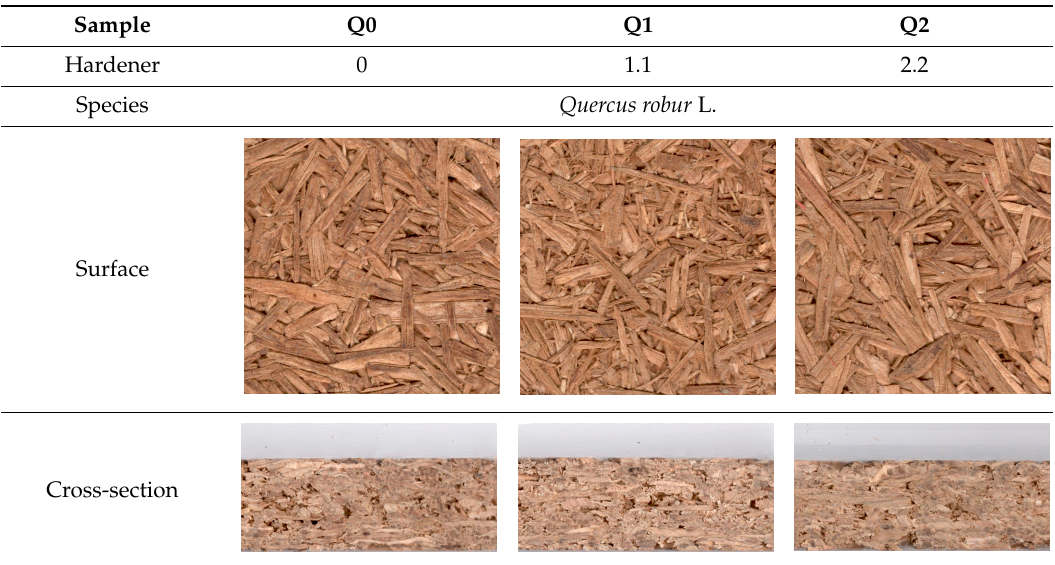
Table 4. Sample appearance of the boards made of oak.